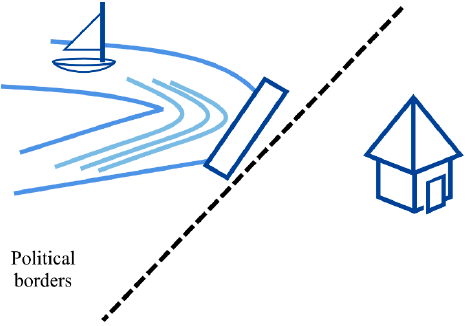
Figure 2. How to modify a flow of water.